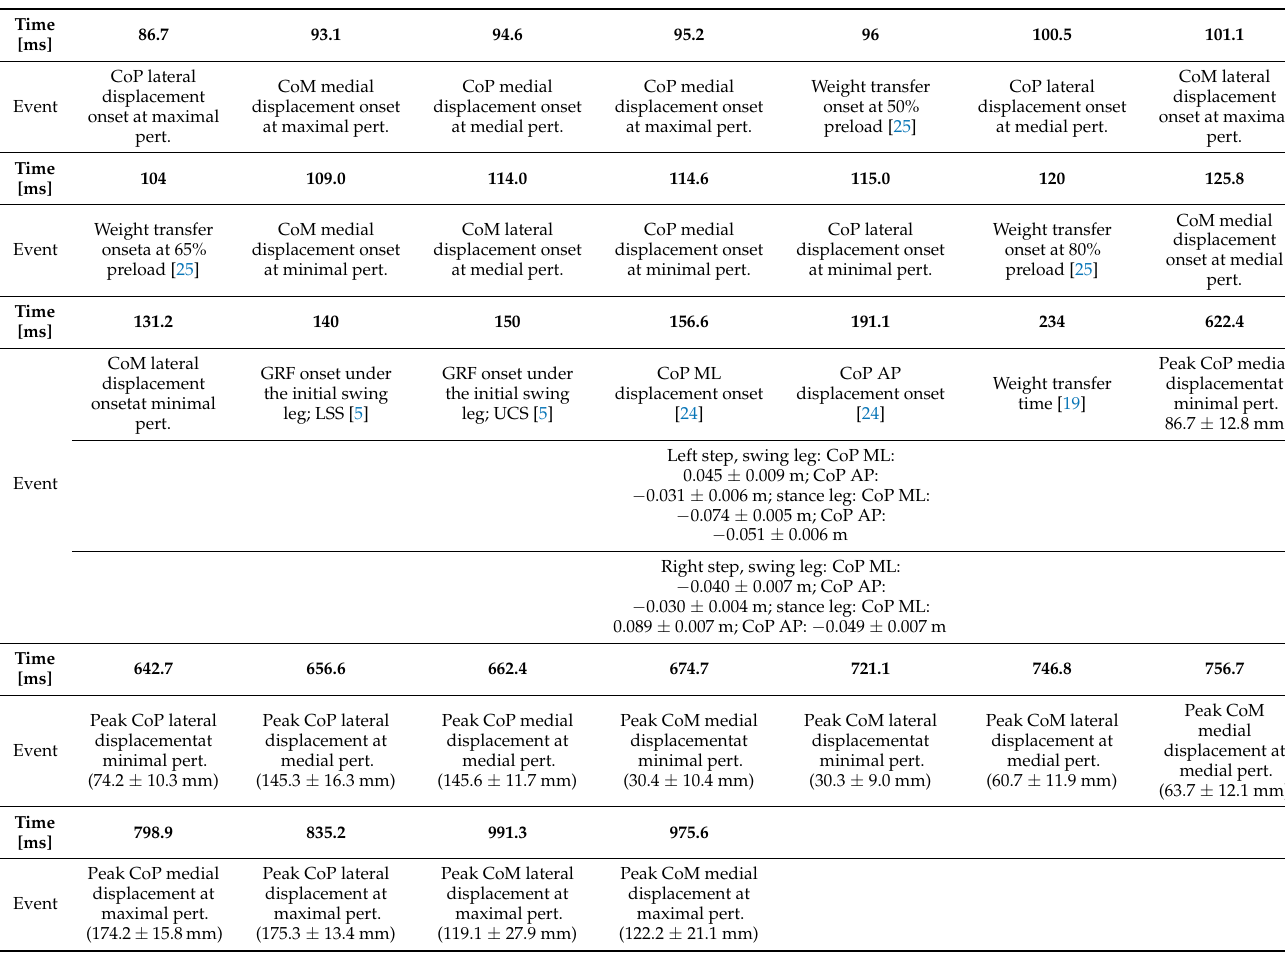
Table A4. A detailed description of the temporal reactions to mediolateral perturbations of the CoP and CoM. The provided data are mainly from the paper